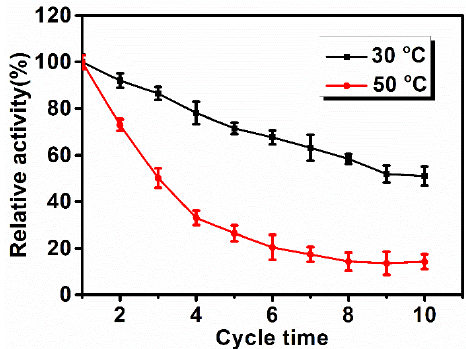
Figure 5. Operational stability of immobilized Lac enzyme at 30 °C and 50 °C.